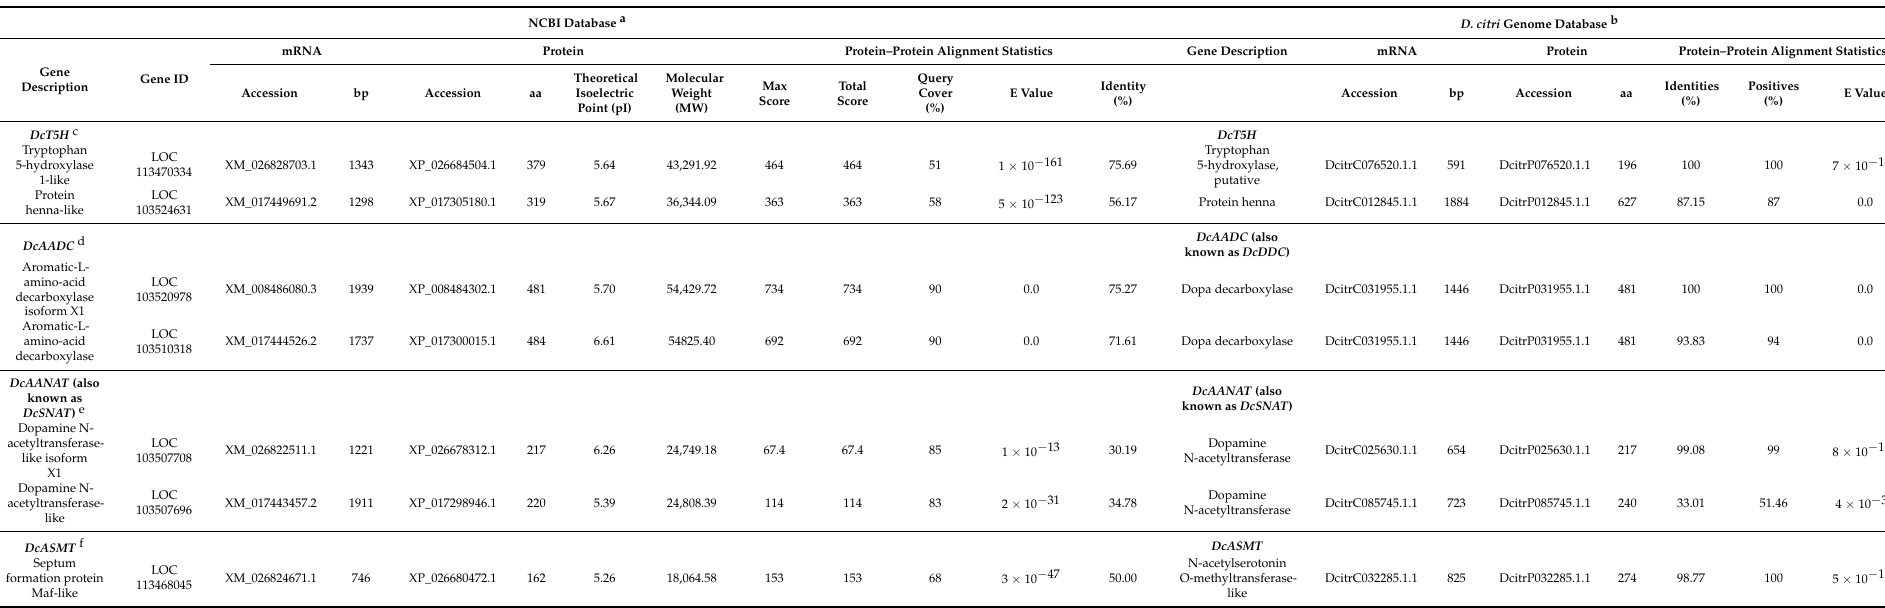
Table 1. Alignment statistics for the top-matched sequences producing significant alignments of melatonin-biosynthetic